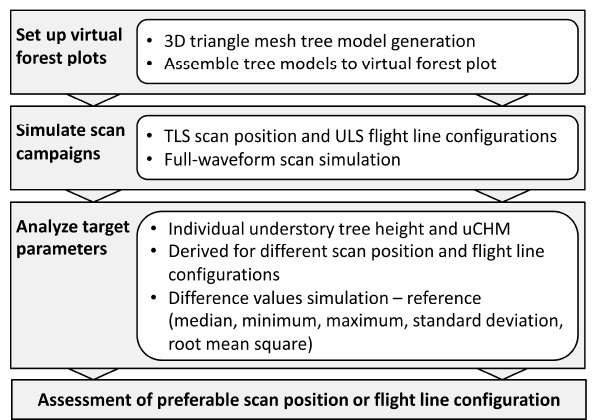
Figure 3: Main processing steps conducted in the study For the TLS case, 26 point clouds are analysed which result from the simulation of different scan position configurations considered to be realistic also in real field work (Table 1, Figure 4).